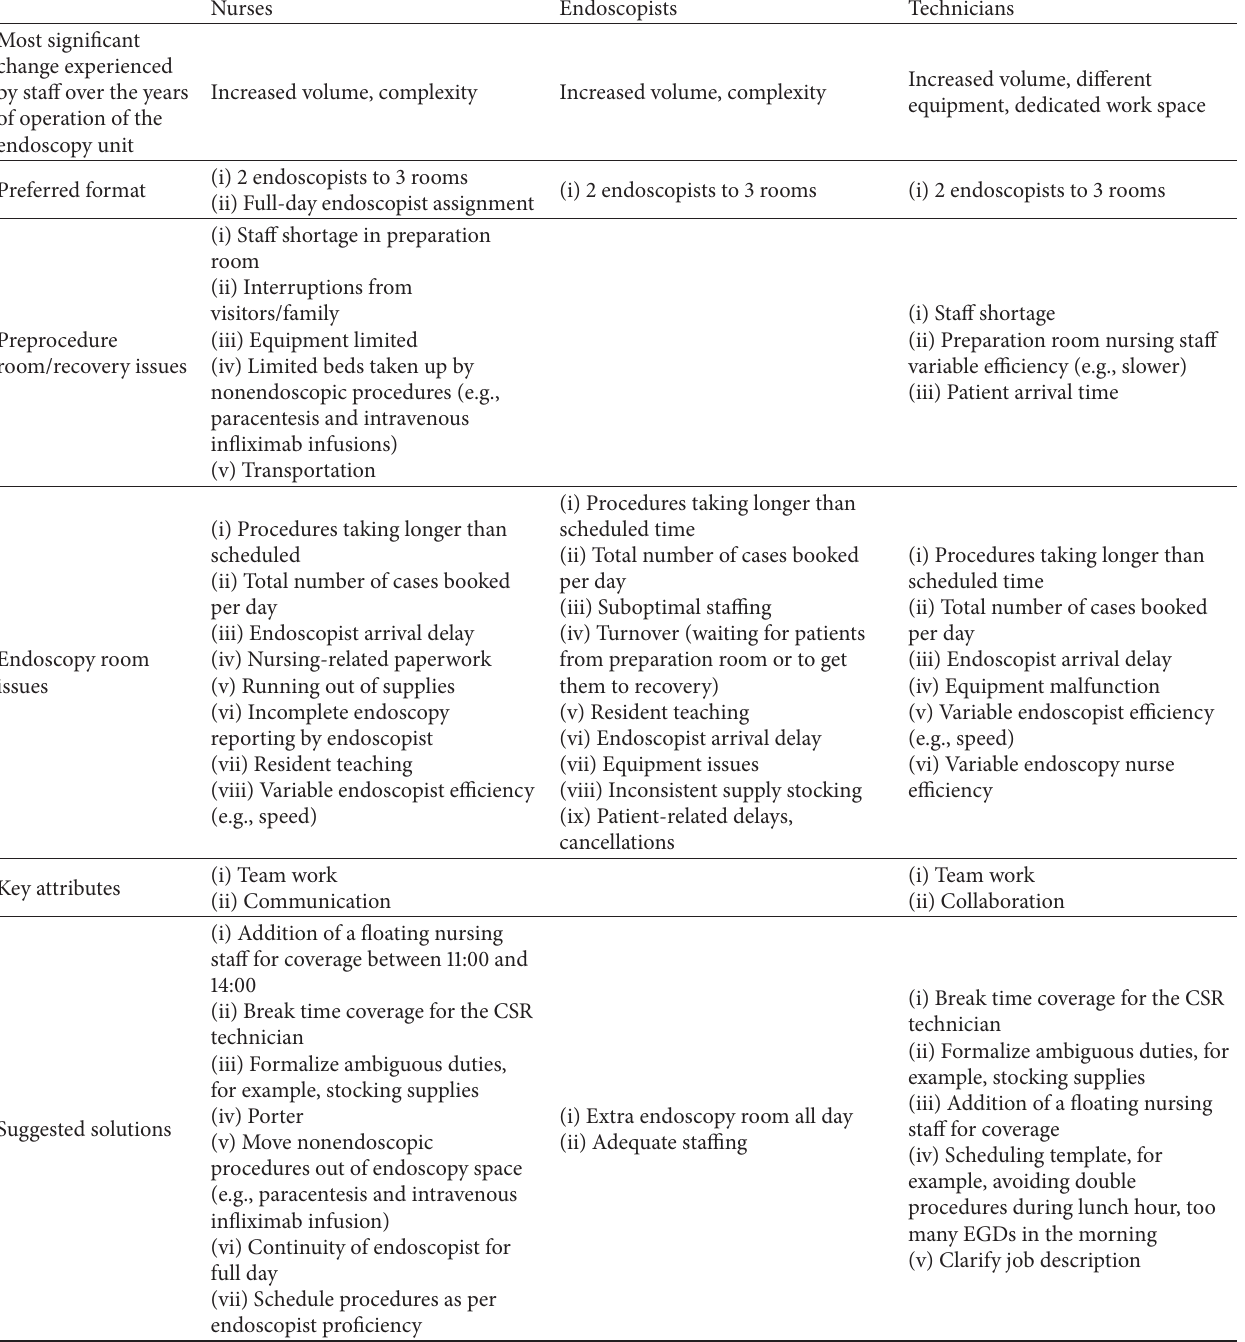
Table 5: Operational inefficiencies as identified by endoscopy